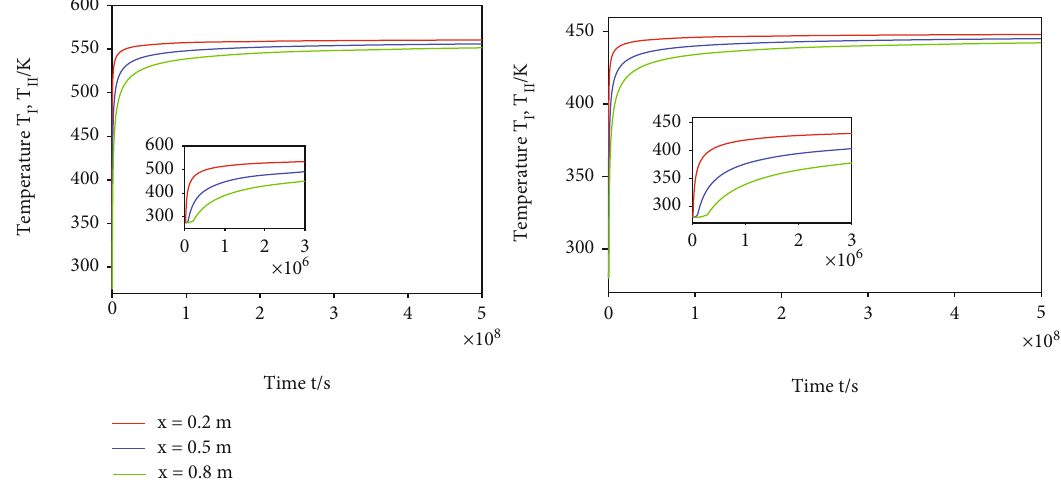
Figure 3: The temperature of steam and hot water varies with